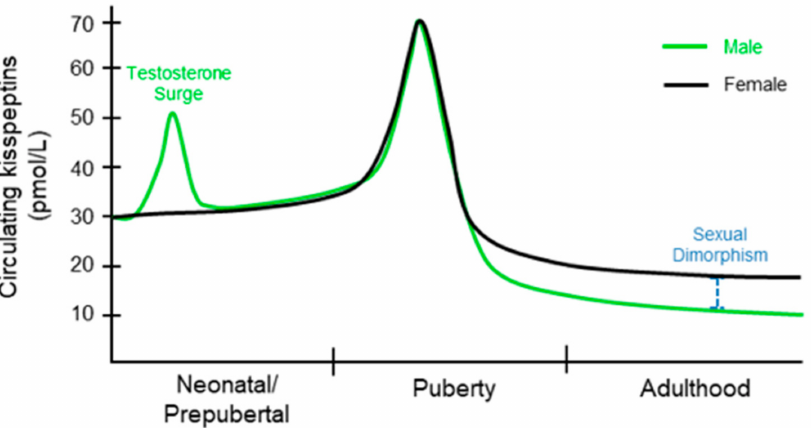
Figure 2. Circulating kisspeptin levels in men and women. Kisspeptins (KPs) are detected in the human plasma. Sex specific events, such as neonatal testosterone surge in males and pregnancy in females, can affect the plasma KP levels. KP levels also change with increasing age but exhibit significant sexual dimorphism after puberty. In both men and women, the highest KP levels are detected during puberty and thereafter, plasma KP levels decrease with